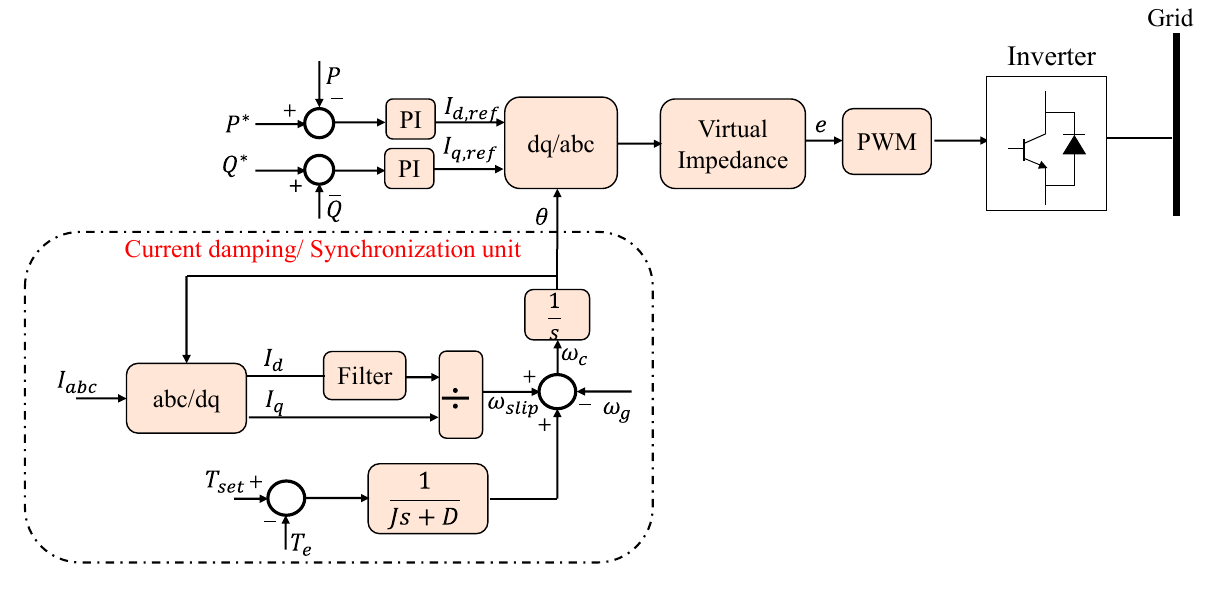
Figure 12. Inducverter control diagram [6,38].